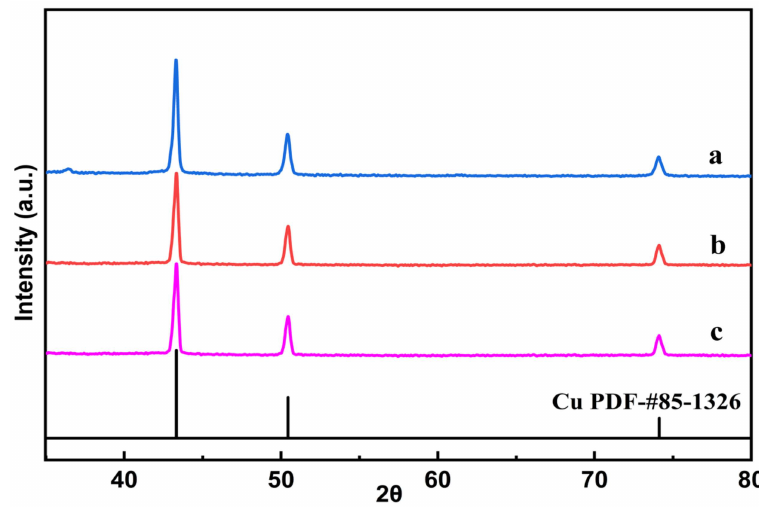
Figure 3. Powder XRD patterns of ( a ) Cu@N-C(400), ( b ) Cu@N-C(600), and ( c ) Cu@N-C(800).